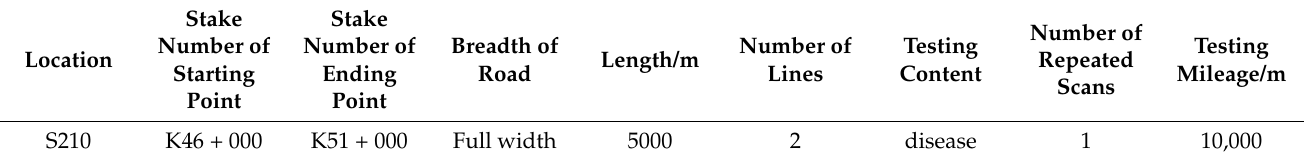
Table 3. Tested road